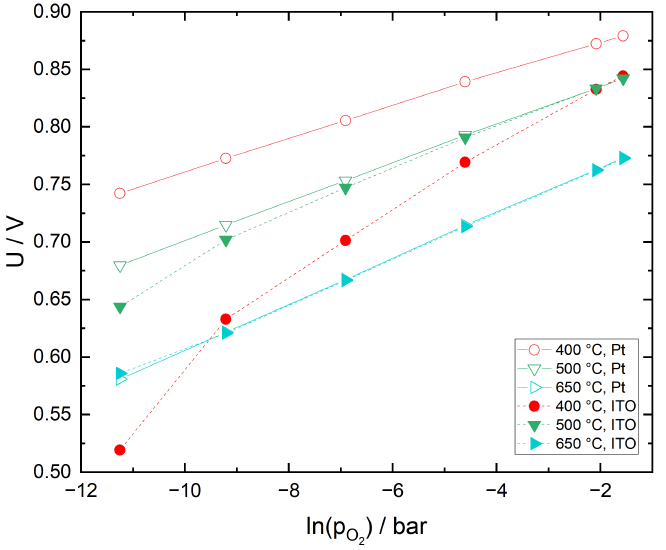
Figure 8. Comparison of sensor voltages for a sensor with Pt cermet versus ITO sensing electrode as function of oxygen partial pressure in N 2 for different